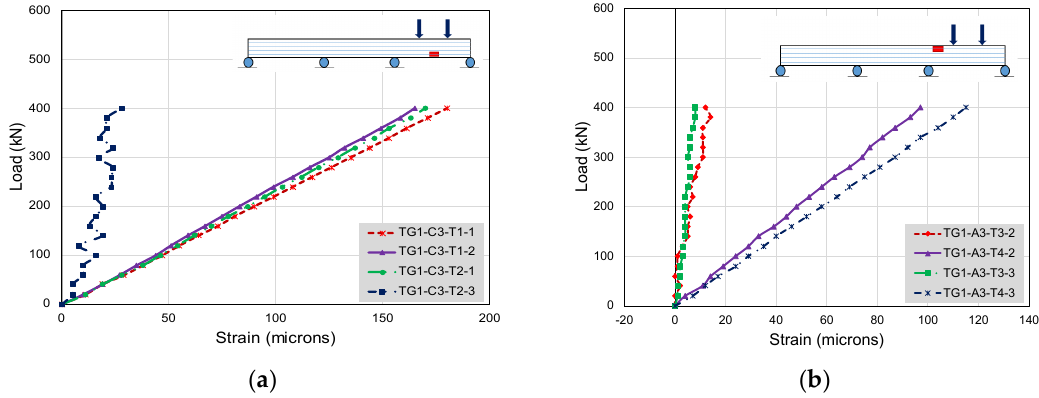
Figure 38. Load versus strain responses in load setup SP-1-L01 ( a ) C3 and ( b ) A3.